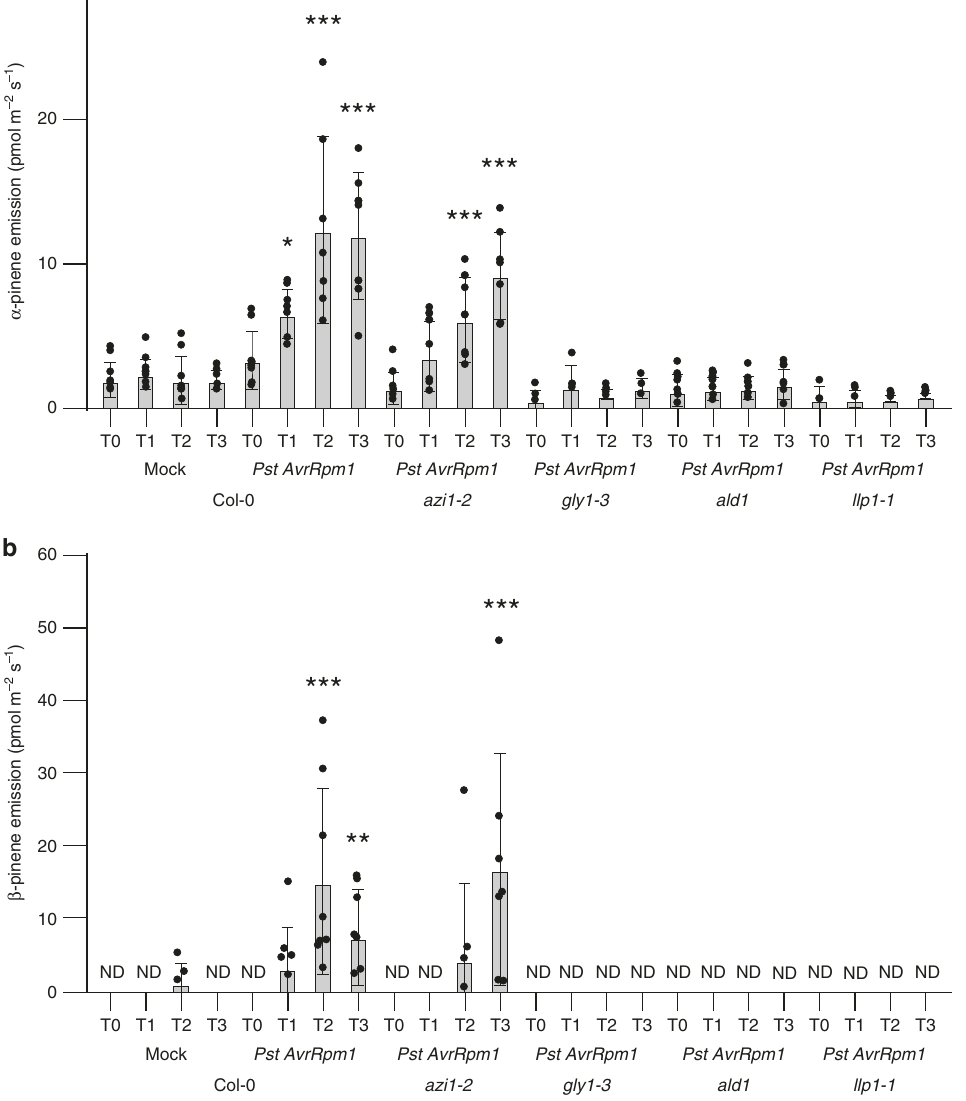
Fig. 4 SAR-induced emissions of the volatile monoterpenes α - and β -pinene depend on LLP1, G3P, and Pip. Emission rates of α -pinene a and β -pinene b from the plant genotypes indicated below the panels 1 day before (T0) and during the fi rst (T1), second (T2), and third (T3) day after spray inoculation of the plants with Pst/AvrRpm1 or the corresponding mock treatment. Dots indicate individual, biologically independent results ( n = 3 – 8); bars represent the average of the indicated results ± standard deviation. Asterisks indicate signi fi cant differences from the respective Col-0 mock control. Genotype main effect: Col-0***, azi1-2 *** ( α -pinene); Col-0***, azi1-2 *** ( β -pinene). Two-way ANOVA, multiple comparison versus control groups, Holm-Sidak method; * P < 0.05, ** P < 0.01, *** P < 0.001. ND: not detectable indicates that the average emission rates remained below background levels. Individual data that were below background levels are not indicated in the bars, but were included in statistical analyses of the data and in the source data fi le associated with this paper. Grubb ’ s outlier test identi fi ed statistically signi fi cant outliers in the data sets Col-0 Pst AvrRpm1 T1 and T2; these outliers were excluded from further analyses and are highlighted in gray in the source data fi when offered GPP as a substrate produces a monoterpene blend tps24 mutants that TPS24 , possibly together with other TPS , that includes α - and β -pinene 36 . Here, we used two independent contributes to monoterpene emissions after infection. In support tps24 mutants carrying T-DNA insertions in the fourth intron of an essential role of monoterpenes in SAR, both tps24 mutants and 3 ′ untranslated region of TPS24 (Supplementary Fig. 7A). In were unable to support SAR after a local Pst/AvrRpm1 infection spite of detectable TPS24 transcript accumulation (Supplemen- (Supplementary Fig. 8). Also, wt receiver plants did not mount tary Fig. 7B), both tps24 mutants had reduced α -pinene emissions enhanced resistance when exposed to the emissions of infected after Pst/AvrRpm1 infection compared with wt plants (Supple- tps24 mutants (Fig. 5i). Similar to ggpps12 plants (Fig. 5b), both mentary Fig. 5). In this experiment, all other monoterpenes tps24 mutants responded to the airborne cues from infected wt remained below the limit of detection, also in emissions of wt plants with enhanced resistance to Pst (Fig. 5j). These data plants. Therefore, we considered α -pinene as representative for strongly support a role of monoterpenes in SAR and as a volatile monoterpenes and concluded from the reduced emissions in both cue in PTP blends.